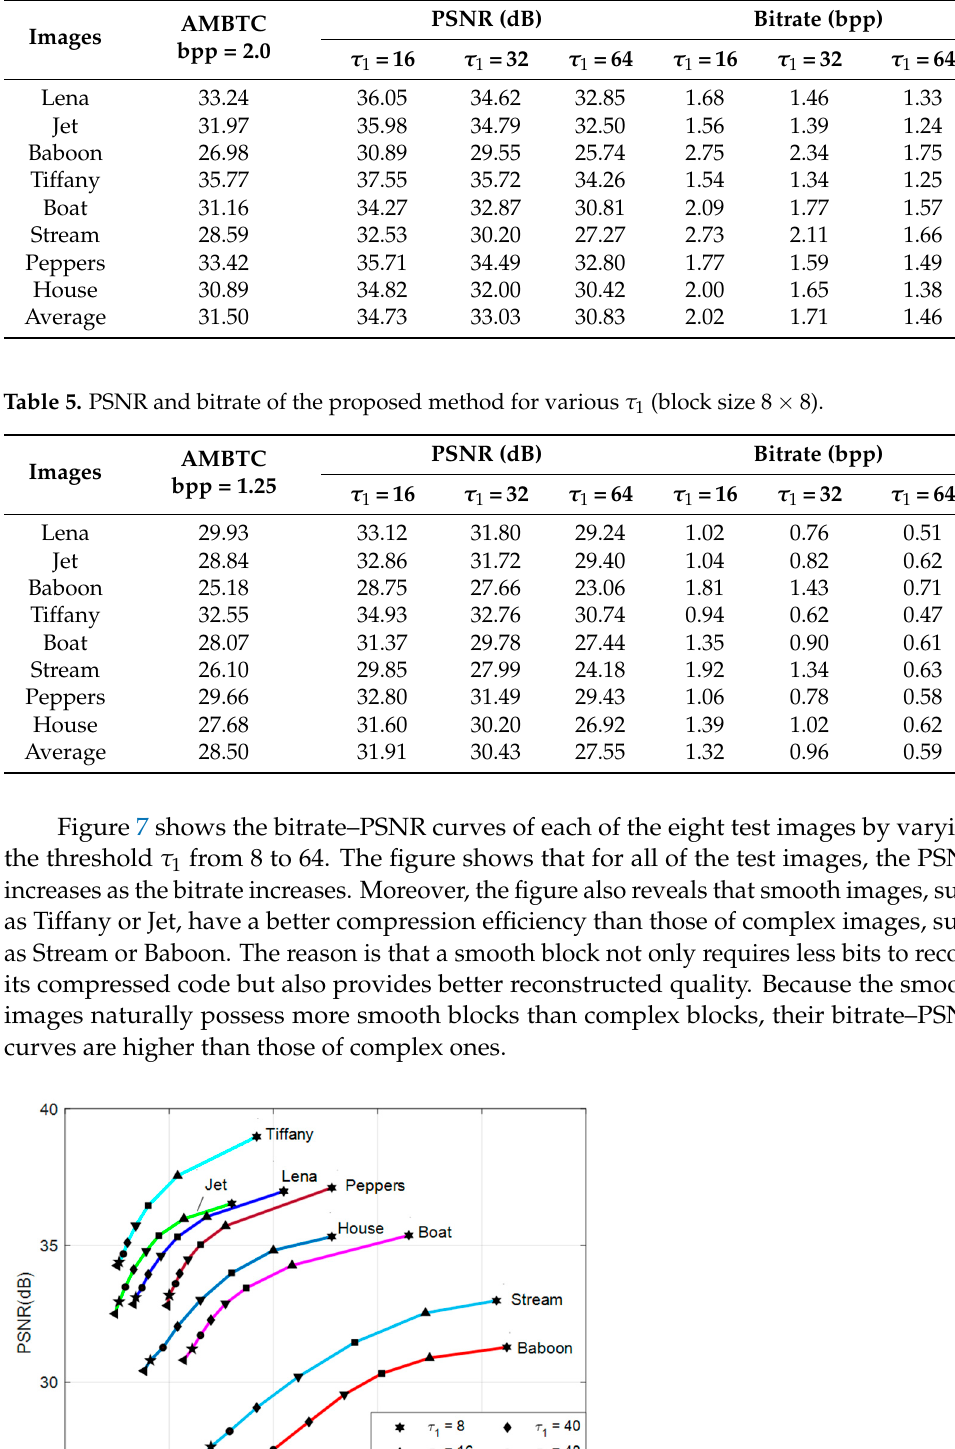
Table 4. PSNR and bitrate of the proposed method for various τ 1 (block size 4 × 4).